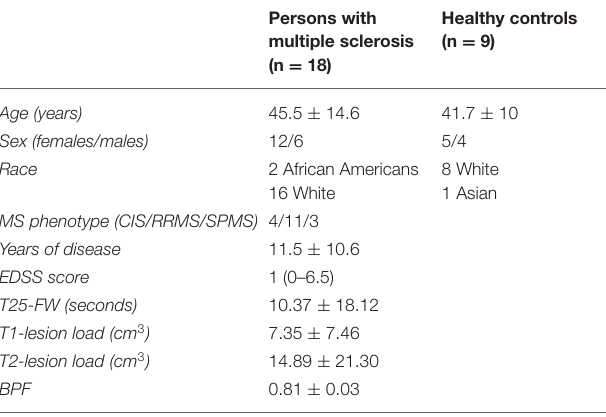
TABLE 1 | Demographic, clinical and imaging features of the study cohort.